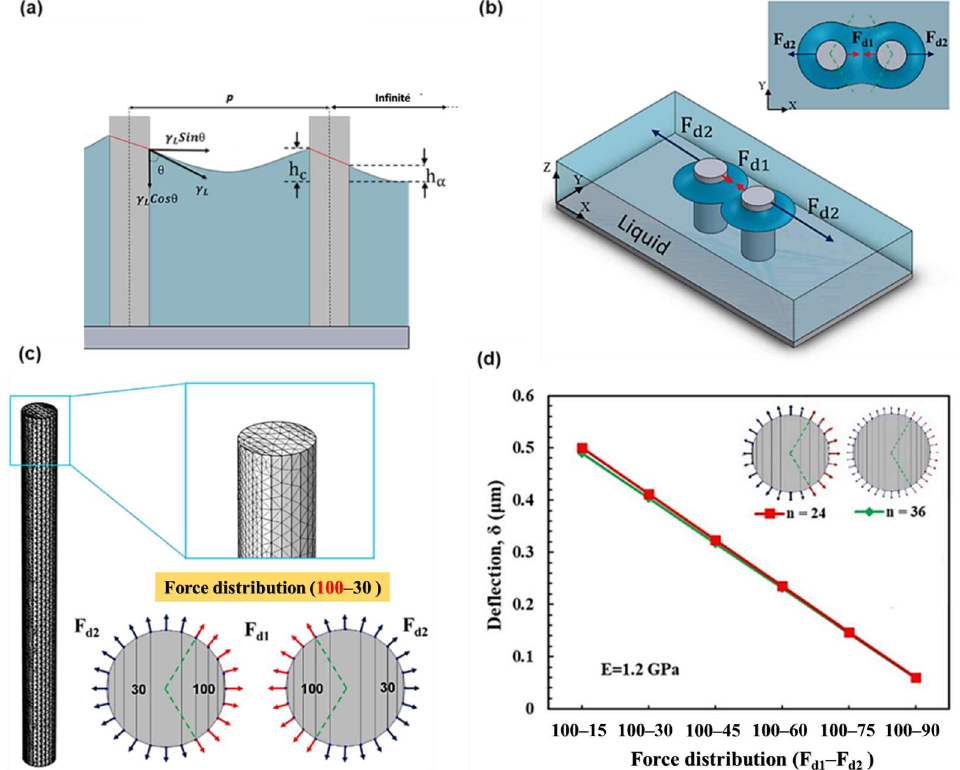
Figure 1. The interaction energy between two micropillars. ( a ) Schematic showing the capillary meniscus around two micropillars partially immersed in water, forming a contact angle of ‘ θ ’. Various spacing of neighboring micropillars leads to the capillary rise on the sides of the micropillar of varying heights, resulting in an unequal force distribution. ( b ) Schematics showing two partially immersed vertical micropillars in water. The dark blue circles around the micropillars are the effective zone of the capillary force and the top right one shows the capillary forces ( F d 1 and F d 2 ) acting on their opposite sides. Effective zone of the capillary force by neighbor micropillar is from 300 ◦ to 60 ◦ , considering the angles measured from the positive x-axis with positive values for counterclockwise. ( c ) Meshing, and force distribution (of 100%–30%) along the circumference of the micropillar (diameter of d = 0.75 µ m and height of h = 9 µ m) used for simulating the deflection, due to the capillary forces. ( d ) Shows the deflection of the micropillar for different number of segments indicating that the number of segments is